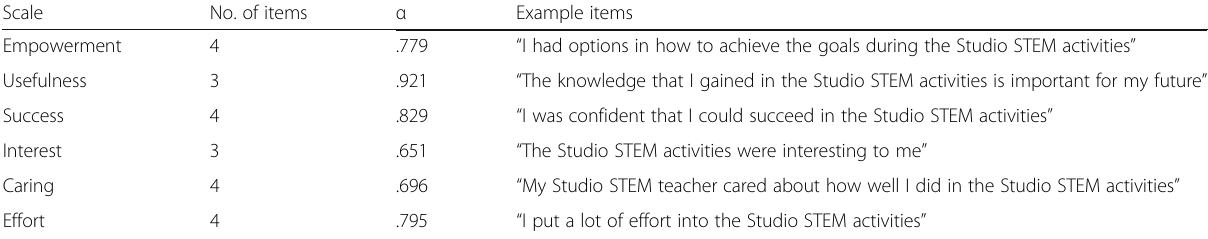
Table 2 Reliability evidence and example items for the MUSIC Inventory-middle/high school version and effort measure Scale No. of items